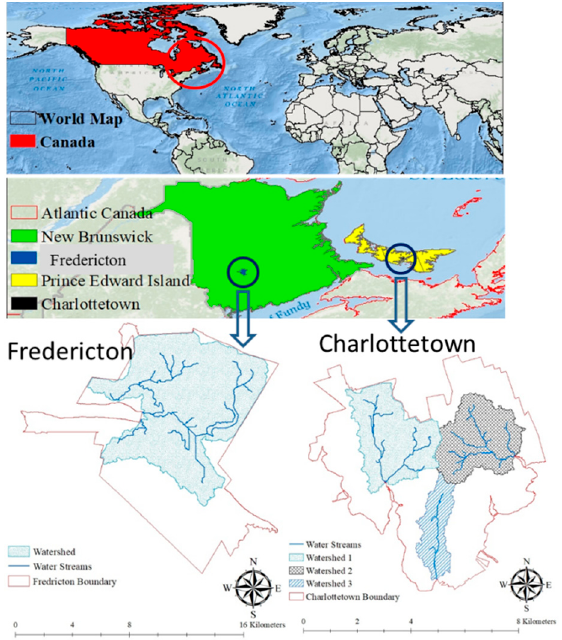
Figure 1. Locations of the model cities Fredericton (bottom left ) and Charlottetown (bottom right ) in Atlantic Canada along with watersheds displayed inside the boundary of the cities. Table 1. Year of establishment / foundation, population, population density, geographical coordinates, elevation, and historical values of precipitation and temperatures of the selected cities of in comparison to country level figures of Canada.